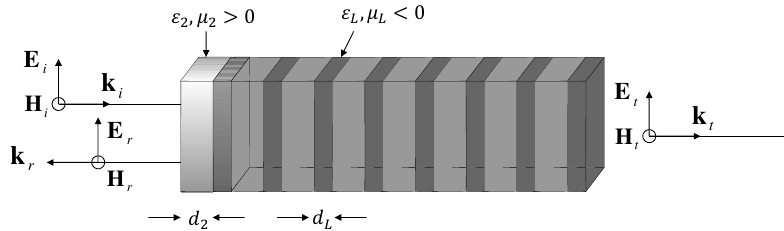
Figure 7. A metamaterial superlattice air ( LR 2 ) n air with n unit cells, where left- and right-handed media alternate. We assume the normal incidence of the electromagnetic field with parallel